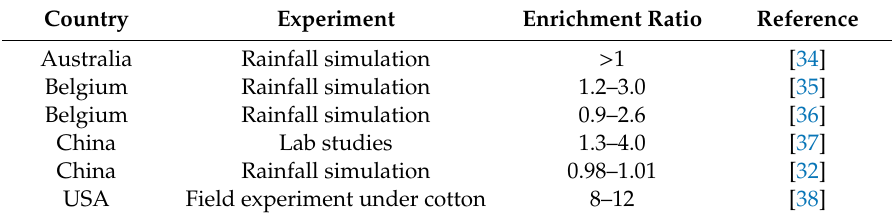
Table 2. The enrichment ratio of carbon in sediments derived from water